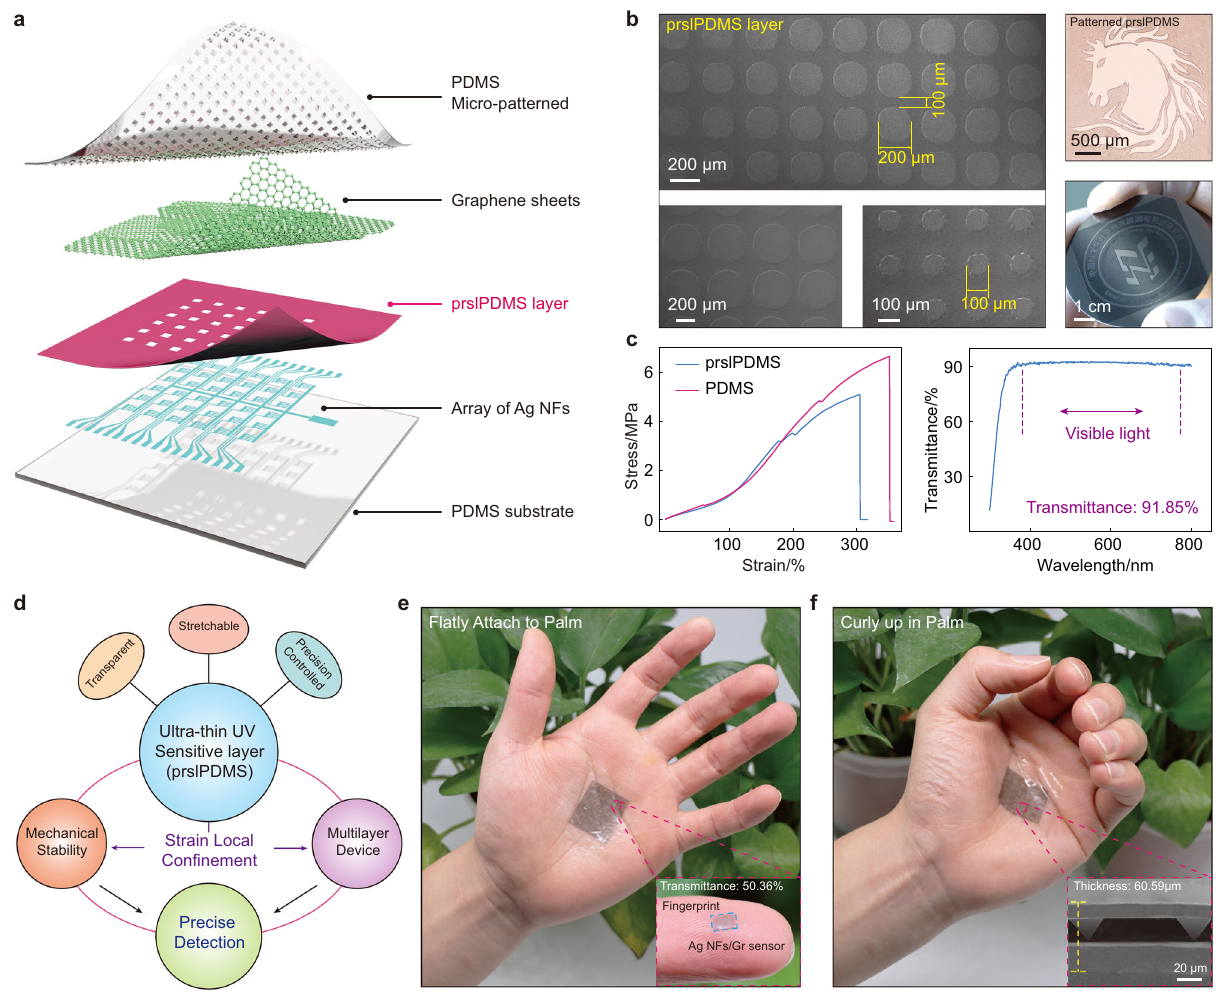
d Schematic showing the design concept for the ultralow crosstalk sensor, where the prslPDMS layer perform the effect of strain local con fi nement for mechanical stabilityaswellasmultilayerdevice.Opticalphotographsofsensorarraysattached onpalmnomatterinthe fl at( e )orcurly( f )state,whichachievethetransparencyof 50.36% and thickness of 60.59 μ